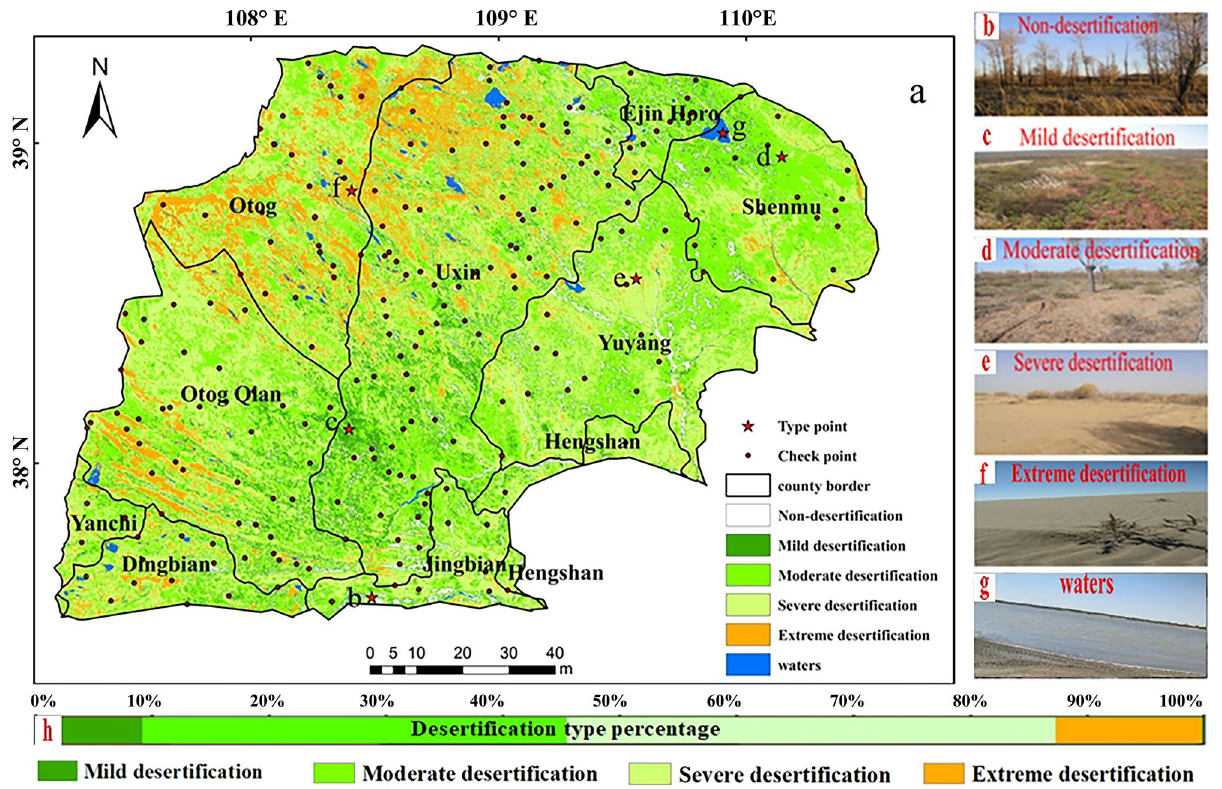
Figure 2. ( a ) Thematic map of the Mu Us Sandy Land in 1995 compiled based on Landsat 5 Thematic Mapper images. Grey circle Check points: based on 2017 desertified land field verification points. Red star Type points: inset photos show typical examples of ( b ) non-desertification, ( c ) mild desertification, ( d ) moderate desertification, ( e ) severe desertification, ( f ) extreme desertification, ( g ) water, ( h ) different desertification type percentage in the study area. The boundary of each flag county in Mu Us Sandy Land is derived from the administrative boundary data of county level in China (http://www.resdc .cn/data.aspx?DATAI